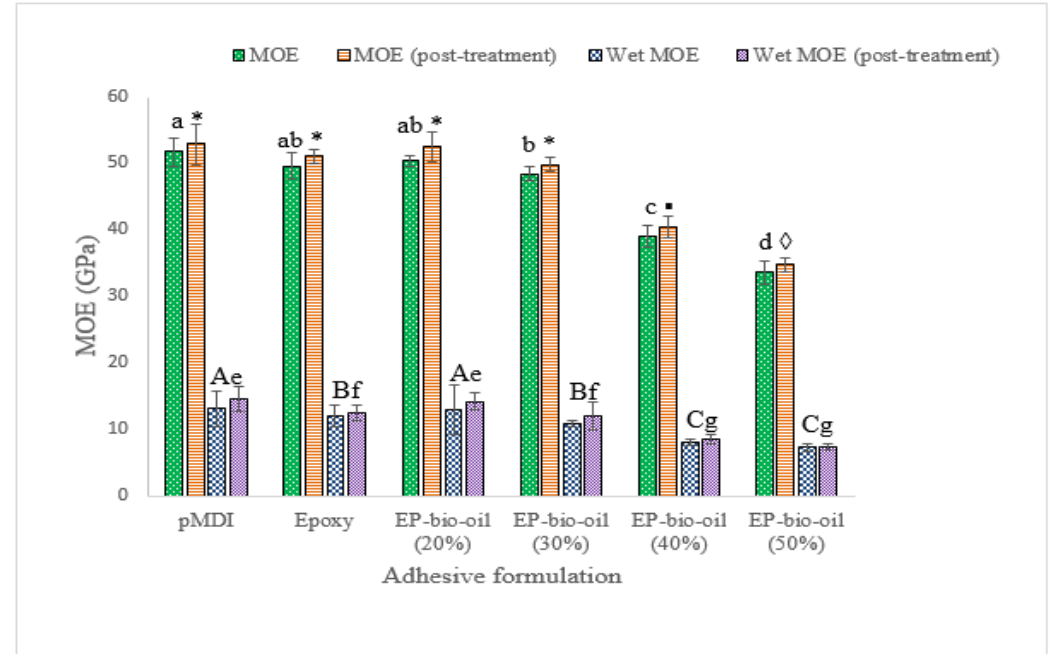
Figure 5. Modulus of elasticity (MOE) of OSB bonded with epoxy resin and epoxy-substituted bio-oil at 20%, 30%, 40%, and 50% bio-oil contents. Wet MOE was analyzed separately. EP-bio-oil (%): epoxy resin substituted with bio-oil. Different letters and symbols on the bar represent significant MOE ( p < 0.05). Post-treated means were analyzed separately. Error bars represent standard deviation.